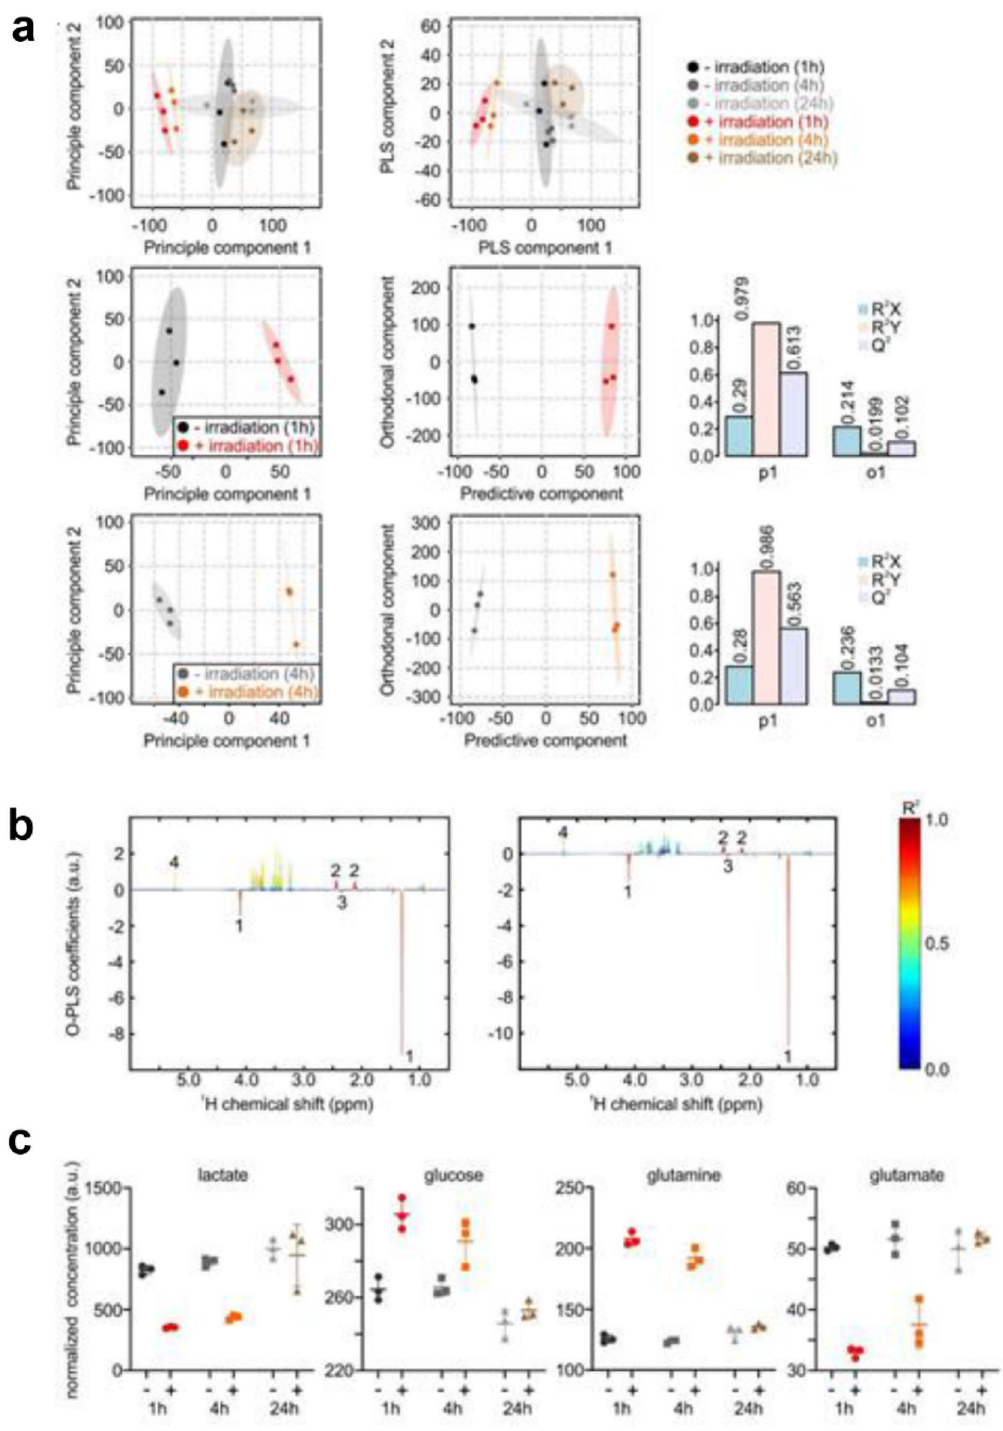
Figure 7. Effect of proton irradiation on the metabolic activity of chondrosarcoma cells. ( a ) Principal Component Analysis (PCA) and (Orthogonal) Partial Least Squares Discriminant Analysis ((O)-PLS-DA) of cell culture supernatants 1 h, 4 h, and 24 h after 4 Gy proton IR versus non-IR control conditions (n = 3). ( b ) Reduced NMR spectra reveal altered metabolites in normalized cell culture supernatants at 1 h (left) and 4 h (right). Positive covariance corresponds to metabolites present at increased concentrations, whereas negative covariance corresponds to decreased metabolite concentrations in supernatants of irradiated samples compared to the corresponding control samples. Predictivity of the model is represented by R2. 1…lactate, 2…glutamine, 3…glutamate, 4…glucose. ( c ) shows the alteration in the normalized concentrations of lactate, glucose, glutamine, and glutamate without (−) and with (+) 4 Gy proton